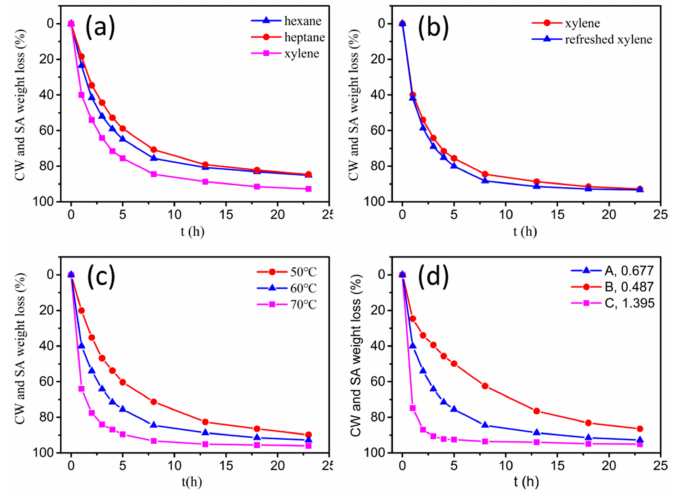
Figure 3. Carnauba wax (CW) and stearic acid (SA) weight loss (wt. %) of: ( a ) Specimens of sample A in different solvents at 60 ◦ C; ( b ) Specimens of sample A in xylene with or without refreshing the solvent at each time-point at 60 ◦ C; ( c ) Specimen of sample A in xylene at different temperatures; ( d ) Samples A, B and C in xylene at 60 ◦